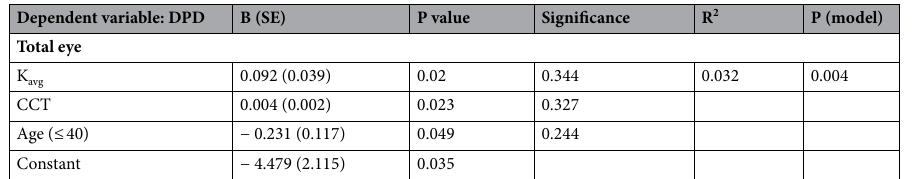
Table 5. Machine learning model with linear regression results. Machine learning: linear regression (forward stepwise). B regression coefficients, SE standard error, R 2 explanation level of the postulated model (coefficient of